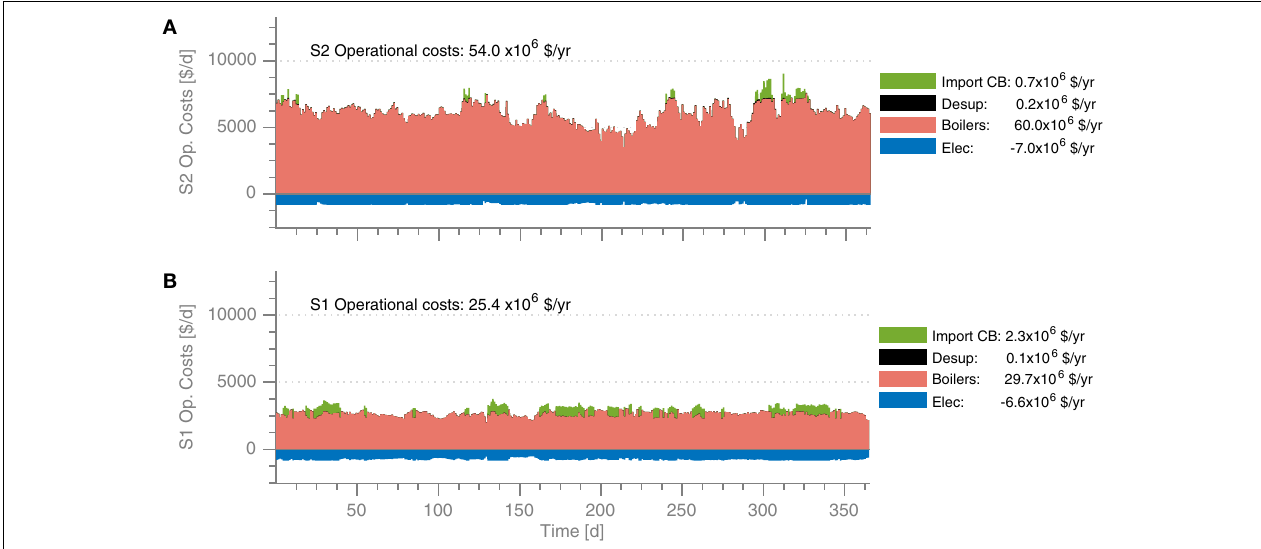
FIGURE 6 | Economic results of steam network optimization under nominal operating conditions for Site 1 (A) and Site 2 (B) .